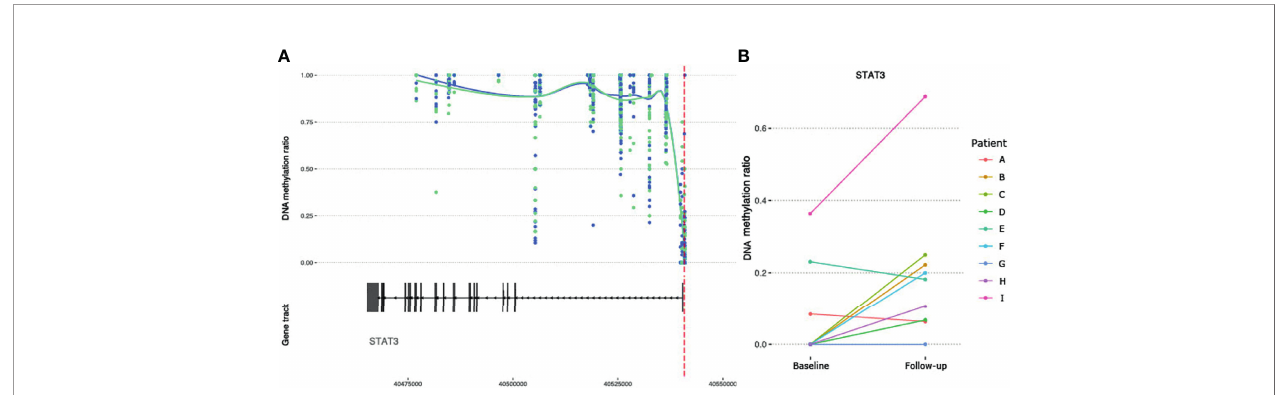
FIGURE 5 | DNA methylation at CpGs overlapping the RA susceptible STAT3 gene. (A) DNA methylation at CpGs (N= 73) overlapping the STAT3 gene. Smoothed lines show mean DNA methylation values for the two patient sampling time points (baseline methylation values in green and follow-up values in blue). The red dotted vertical line marks the position of the signi fi cant DMP. (B) Intra-individual changes in DNA methylation between baseline and follow-up for the signi fi cant DMP in STAT3 . RA, Rheumatoid arthritis; STAT3, Signal transducer and activator of transcription 3; DMP, Differentially methylated